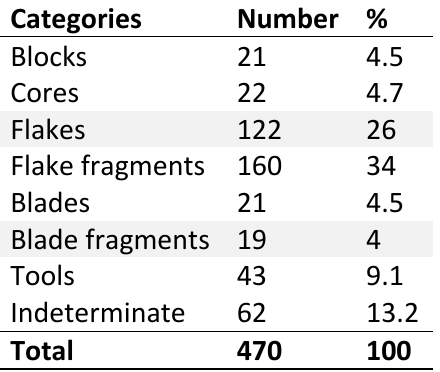
Table 1. Categories of the analysed materials.